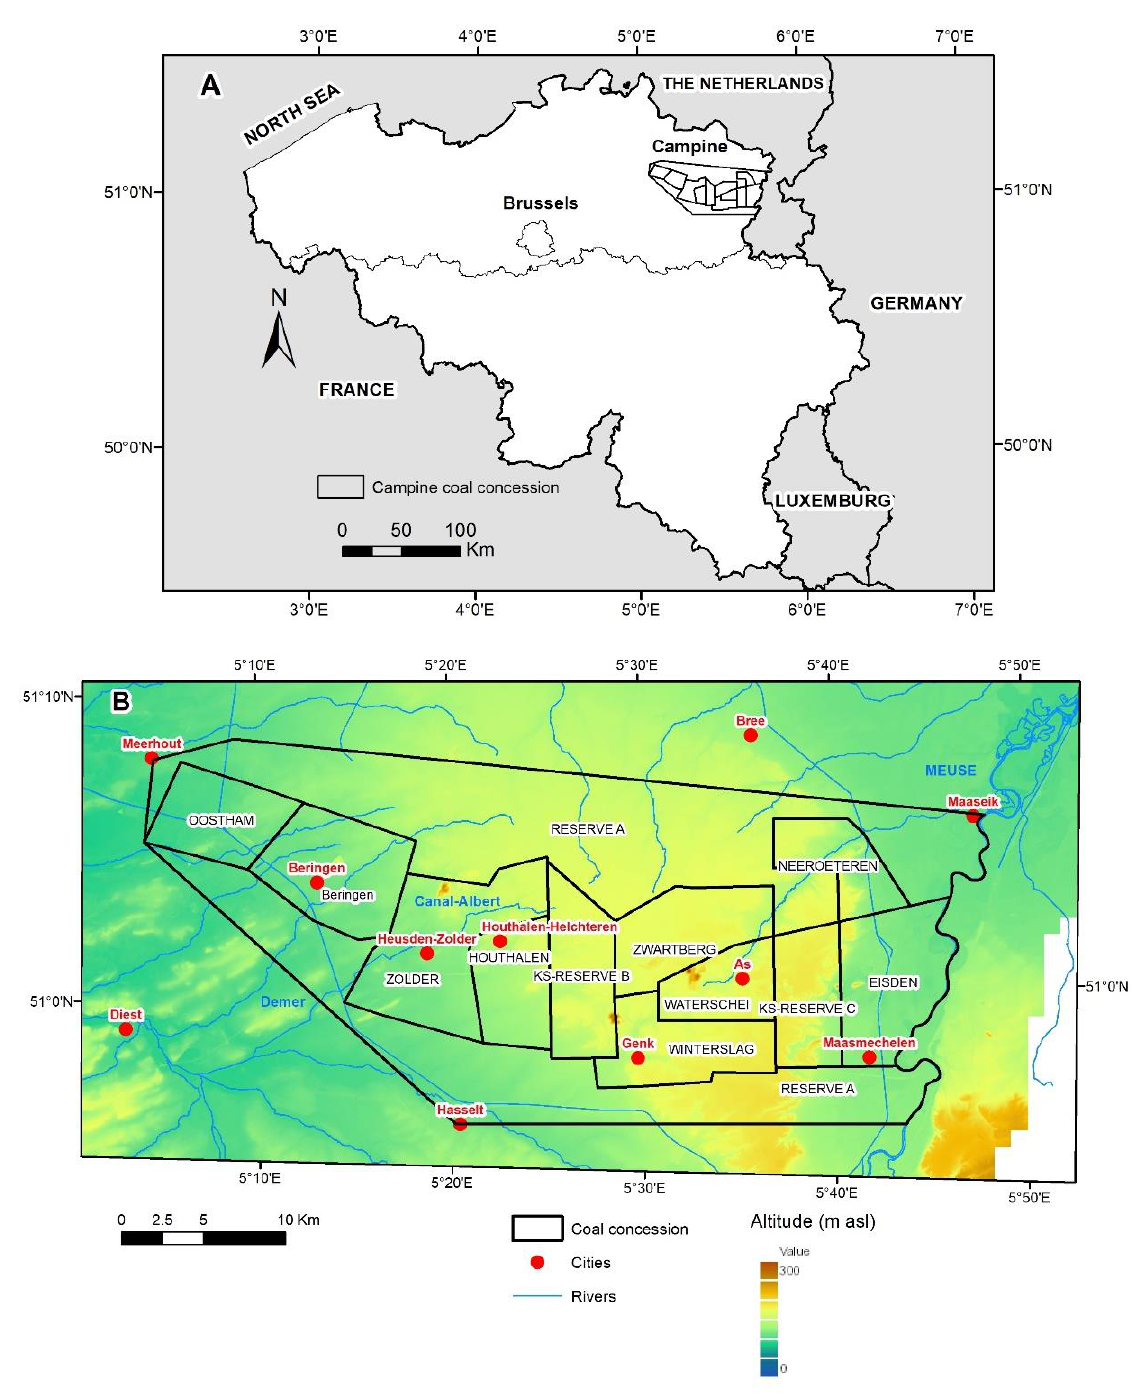
Figure 1. ( A ) Location of the Campine Coal Basin in Belgium; ( B ) major cities, rivers, and DEM (from the databank of Vlaanderen) around the former coal-mining concessions in the study area; the original coal-mining concessions of the Campine coalfield are shown since they are the most instructive features highlighting the physical effects left by the mining industry. Reserve A, KS- Reserve B, KS-Reserve C, Oostham, and Neeroeteren concessions have not been